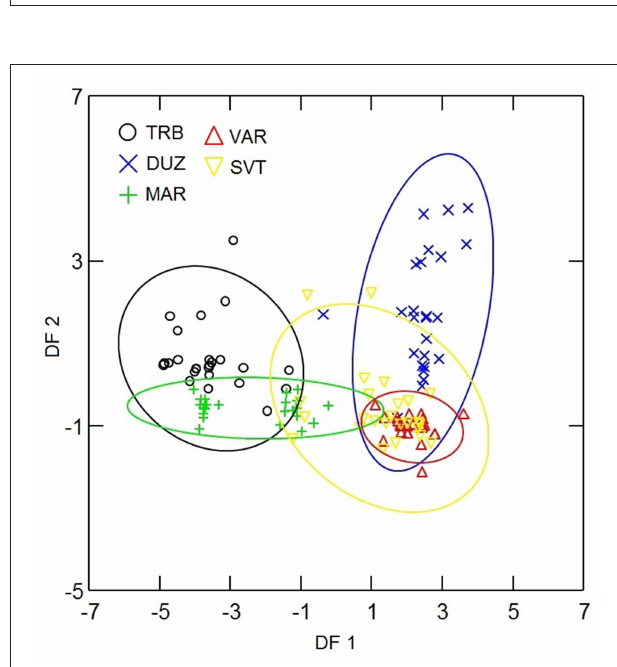
FIGURE 3 | Ninety-five percent confidence ellipses of DFA scores for microsatellite analysis of populations. The abreviations of the samples were given in Figure 1